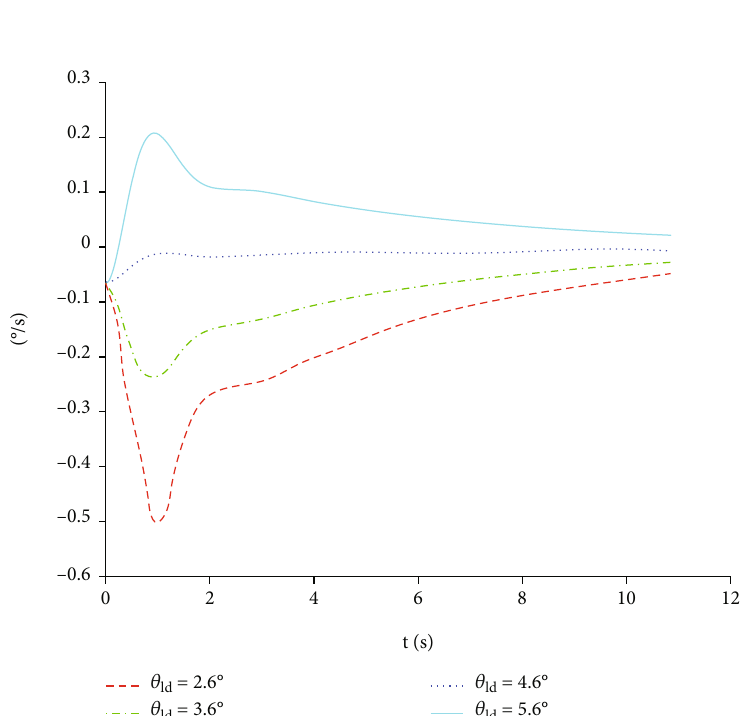
Figure 4: Change curve of LOS angular.